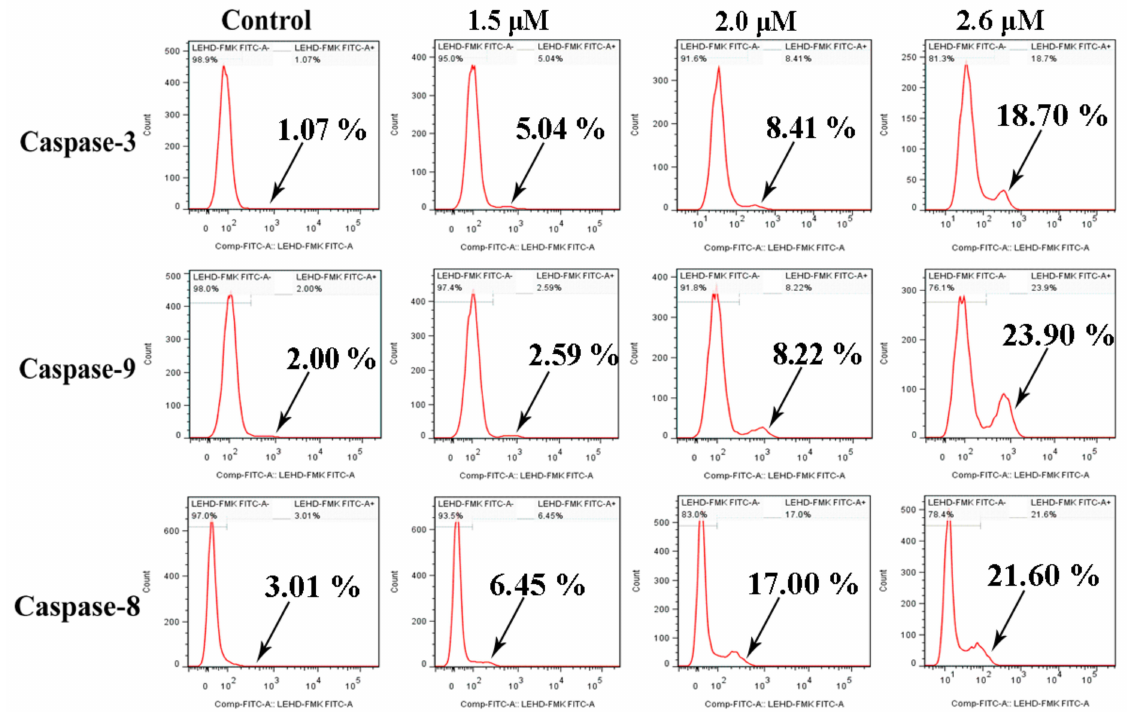
Figure 12. The activation of caspase-3, caspase-8, and caspase-9 in MGC80-3 cells treated with complex 1 (1.5, 2.0, and 2.6 µ M) for 24